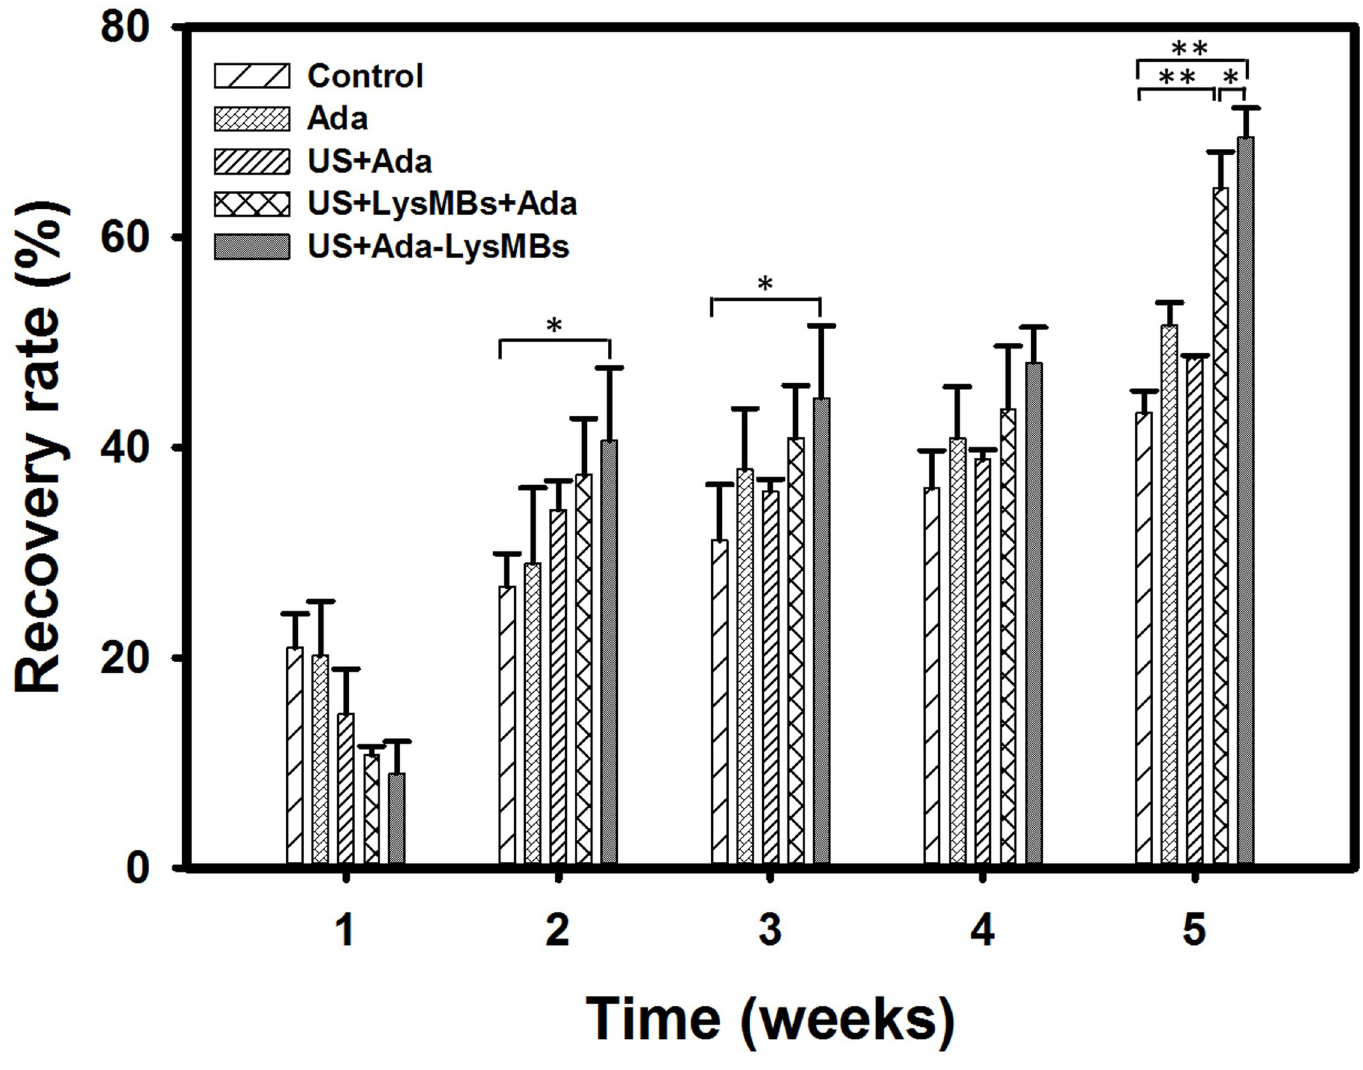
Fig 9. The recovery rate of photoaged skin of mice. The wrinkle areas of the mice were calculated using the detected edge, and the Canny method in MATLAB. � p < 0.05 �� p <